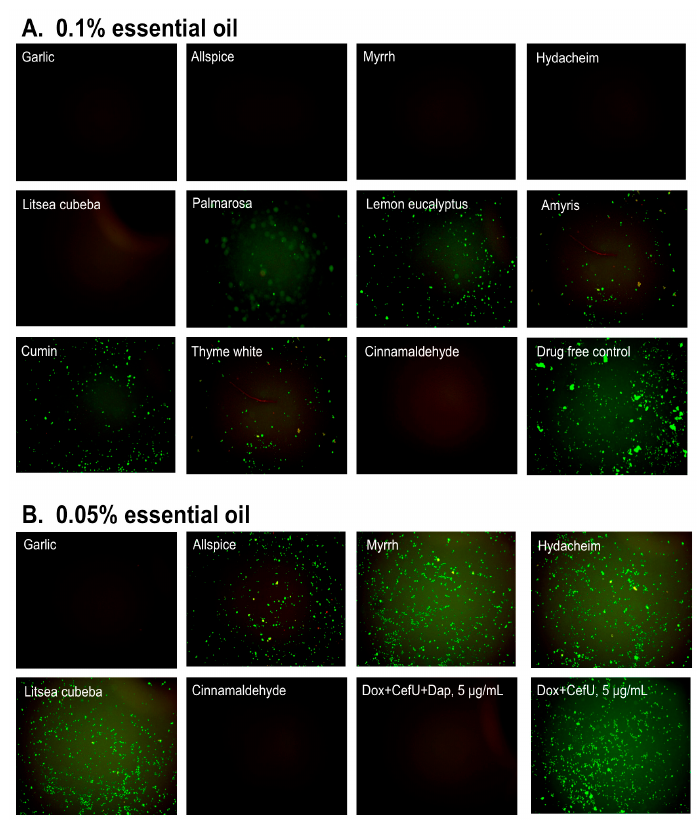
Figure 4. Subculture of B. burgdorferi after treatment with essential oils. A B. burgdorferi stationary phase culture (seven-day old) was treated with the indicated essential oils at 0.1% ( A ) or 0.05% ( B ) for